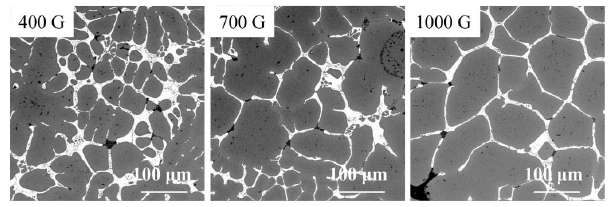
Figure 11. Morphology of layer 3 (( a ): 400 G ; ( b ): 700 G ; ( c ): 1000 G ) and layer 4 (( d ): 400 G ; ( e ): 700 G ; ( f ): 1000 G ) in the residual part (609 °C). 4.3. Effect of Separation Time The experiment with the separation time of 1 min was carried out at 625 °C with the gravity coefficient of 700 G (trail 10) to investigate the influence of separation time on the separation effect. The relevant data is very close to that of trail 8, such as the weight of filtrate, the content of tramp element on layer 1–4, the removal ratio of tramp element. It is indicated that the separation rate of